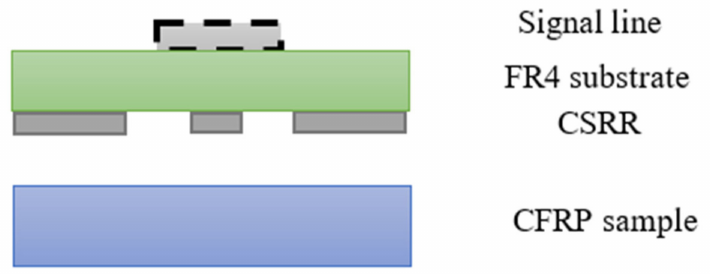
Figure 11. Side view of the complementary split-ring resonator (CSRR)